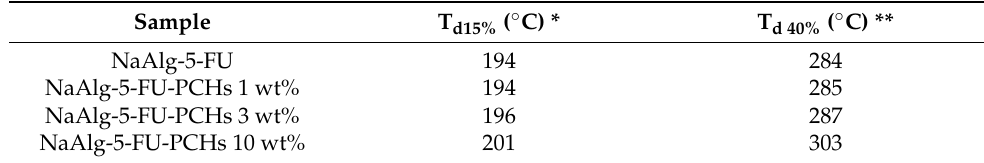
Figure 4. TGA curves of 1-NaAlg-5-FU, 2-NaAlg-5-FU-PCHs 1 wt%, 3-NaAlg-5-FU-PCHs 3 wt%, 4-NaAlg-5-FU-PCHs 10 wt%. Table 2. Thermal properties of hybrid beads.